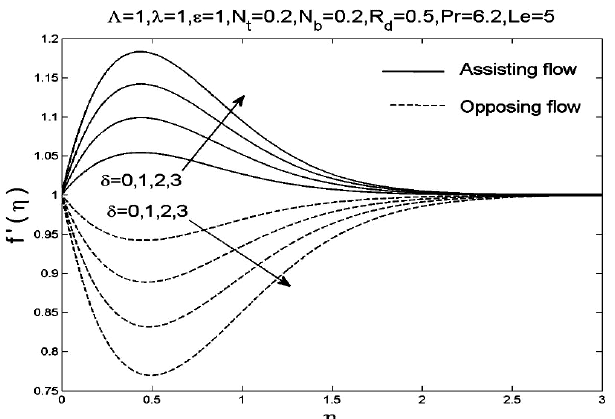
Fig. 4. The effect of the solute buoyancy parameter on the veloc- ity profiles ( ) f η′ .